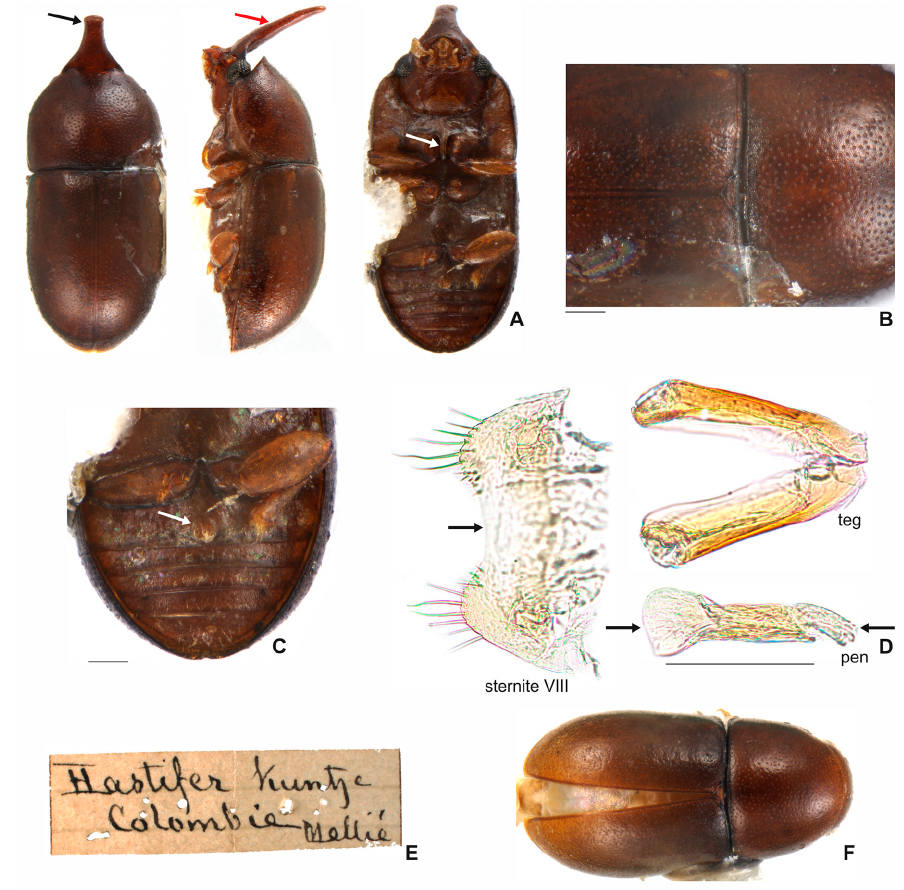
Figure 9. Ceracis hastifer Mellié. A − C Male lectotype, ( A ) dorsal, lateral and ventral views, respectively. Frontoclypeal ridge strongly produced forming a long and narrow upward directed median horn (black arrow); laminate in lateral view (red arrow); prosternal process thin (white arrow), ( B ) pronotal punctation, ( C ) first abdominal ventrite with a sex patch at the centre (white arrow), ( D ) male terminalia in a paralectotype, showing sternite VIII with a deep concave emargination at the middle of the posterior edge (black arrow); tegmen (teg), penis (pen) with membranous apical and basal portion (arrow), ( E ) labels of the lectotype deposited in the Muséum d’Histoire Naturelle, MHNG (Géneve, Switzerland), ( F ) female plesiotype from Peru. Scale bars: A = 0.5 mm, B − D = 0.1 mm, F = 0.5 mm. Diagnosis. The base of the frontoclypeal horn in males does not have lateral inflection and the horn is expanded until one third of its length. The antennal funicle has four antennomeres, the first being shorter than the following three antennomeres together. The anterior portion of hypomera has